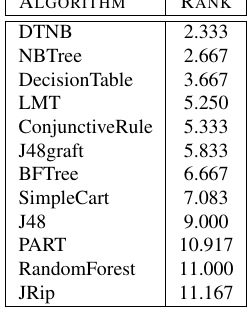
Table 3: Subset of recommended algorithms for educational dataset12 and their ranking